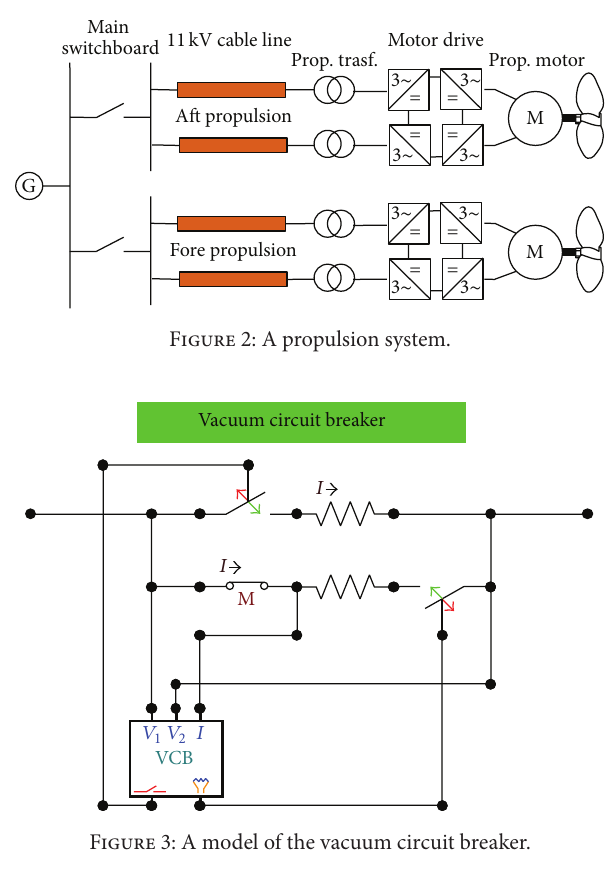
Figure 3: A model of the vacuum circuit breaker.